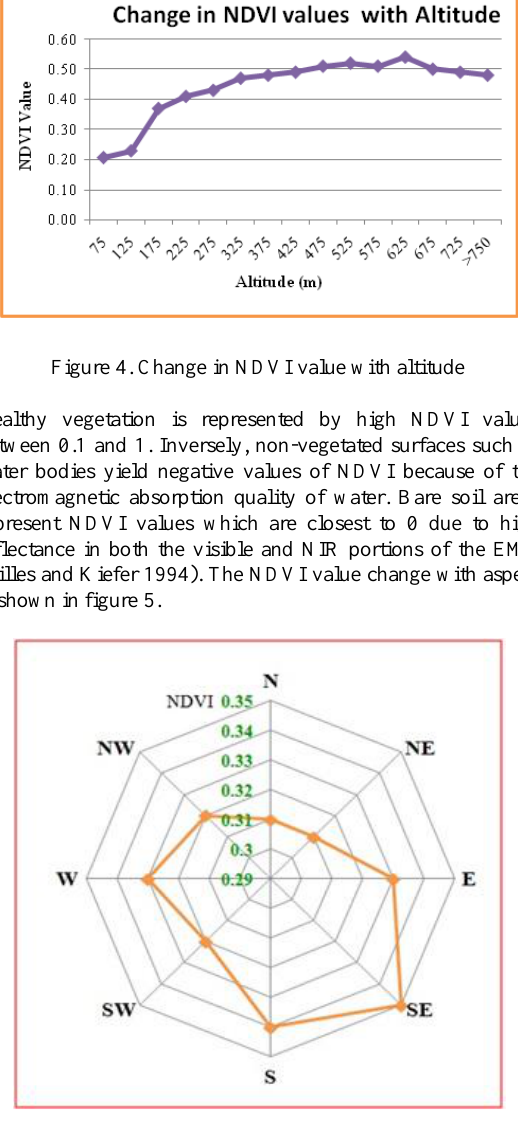
Figure 5. Change in NDVI value with